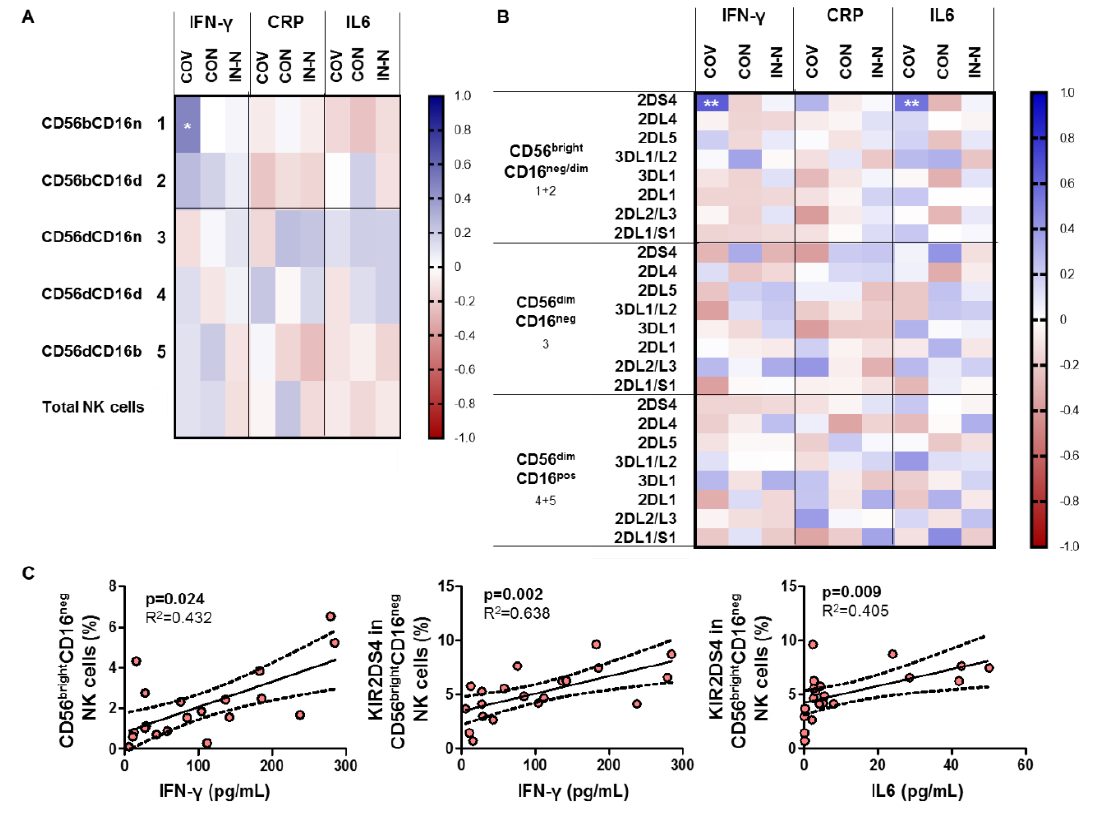
Figure 4. Association of NK cell subsets and KIRs with inflammatory markers. Heatmap graphs representing correlations between the percentages of NK cell subsets ( A ) and KIR receptors ( B ) with inflammatory marker levels in COVID-19 patients, convalescents, and infection-naïve individuals. The blue color represents a positive correlation and the red color represents a negative correlation. The intensity of the color indicates the R 2 coefficient. ( C ), correlation graphs for those correlations that are significant in A and B. Statistical significance data are highlighted with white squares. * p < 0.05; ** p < 0.01. Spearman test was used for nonparametric correlations.